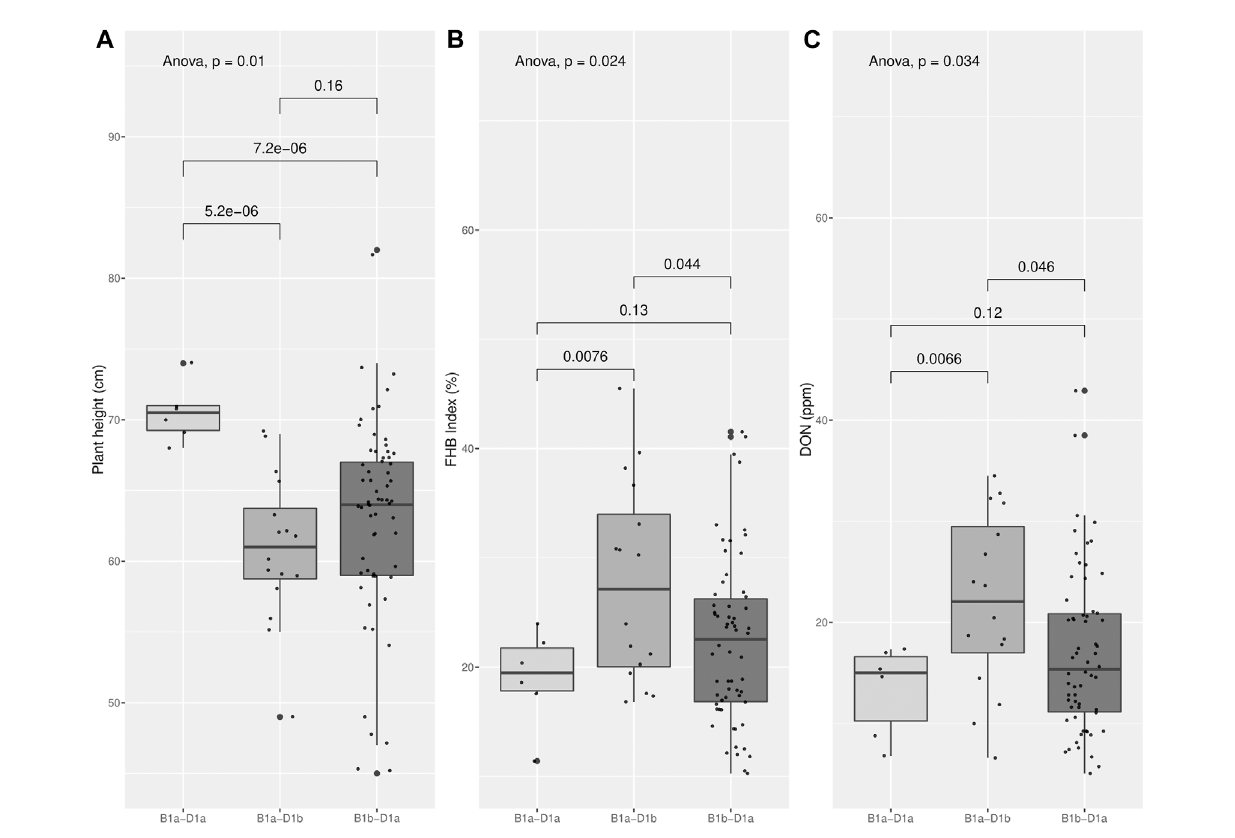
FIGURE 7 Plant height (A) , FHB index (B) and DON accumulation (C) in the wheat collections tested atMorden in 2017 and 2018 classi fi edby the presence ( “ a ” haplotype)orabsence( “ b ” haplotype)ofthemutationat Rht-B1 and Rht-D1 genespredictedbymolecularmarkers.Effectofeachclass B1a-D1a , B1a-D1b and B1b-D1a in those traits and comparison of the means of each paired class